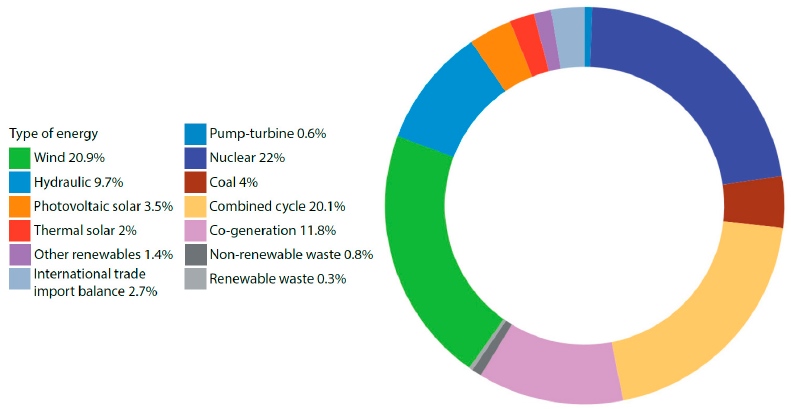
Figure 1. Coverage of the electricity demand in the Iberian Peninsula. Year 2019. Recovered from [2]: https://www.ree.es/es.